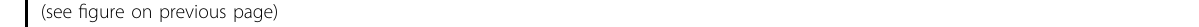
Fig. 3 Dynamic proteomics pro fi ling. a The four clusters of proteins with different expression dynamics for the SC and LC groups computed with Mfuzz analysis (one-way ANOVA, B-H adjusted P -value < 0.05, more details in Supplementary Table S2b). b – d Pathways enrichment by ingenuity pathway analysis (IPA) for the proteins in Clusters 1, 2, and 4 of the SC and LC groups. e – g Heatmaps showing the unique proteins of the SC and LC groups in Clusters 1, 2, and 4 (more details in Supplementary Table S2b), as well as the corresponding top two pathways annotated by IPA ( P - value < 0.05). Proteins highlighted in red are discussed in the main text. h Pathways enriched by IPA ( P -value < 0.05) across the nine weeks (no pathways were enriched for the 3rd, 5th, or 9th weeks) using the differentially expressed proteins between the LC and SC groups (Supplementary Table S2d). The z -score represents the activation state of the pathways: z -score > 0 means the pathway is active, while z -score < 0 indicates that the pathway is inhibited. i The relationship between LXR/RXR and their downstream proteins which uniquely belong to the LC (lipid metabolism- associated proteins) and SC (in fl ammation response-associated proteins) groups in Cluster 1 ( a ). Blue: downregulated proteins/metabolites in the LC group at the 1st week; red: upregulated proteins/metabolites in the LC group at the 1st week; gray: no signi fi cantly different molecules were found between the two groups at the 1st week. The interactions retrieved from STRING are visualized with